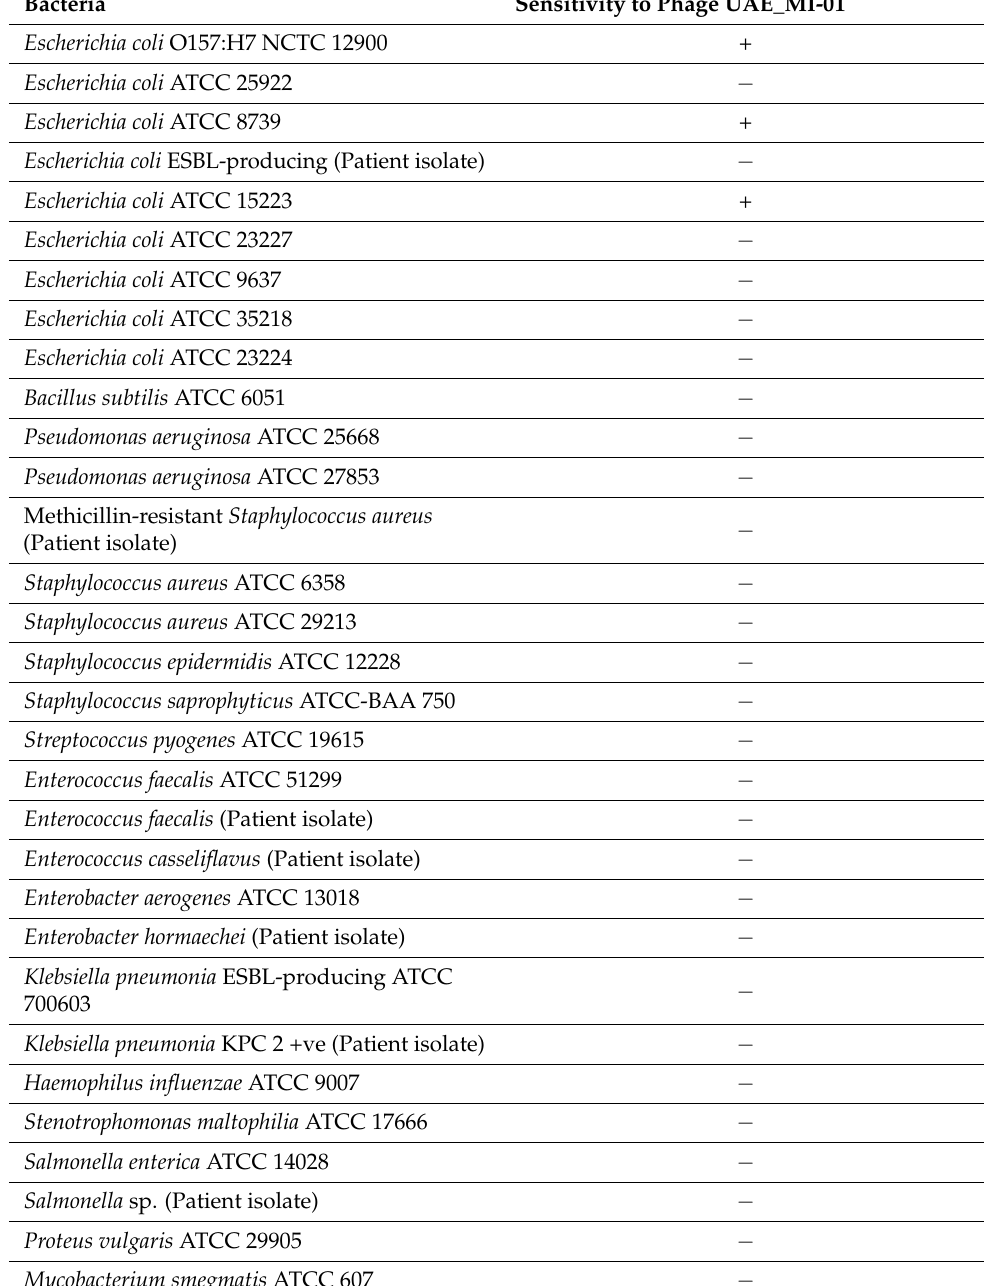
Table 1. Host range of the phage